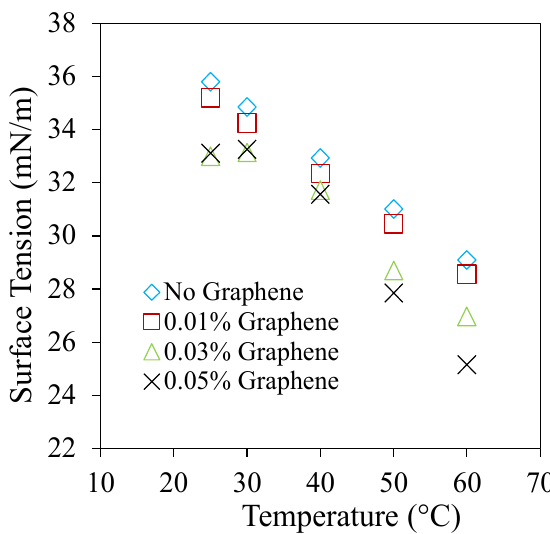
Figure 4. Variation of surface tension of graphene–transformer oil nanofluid with temperature.